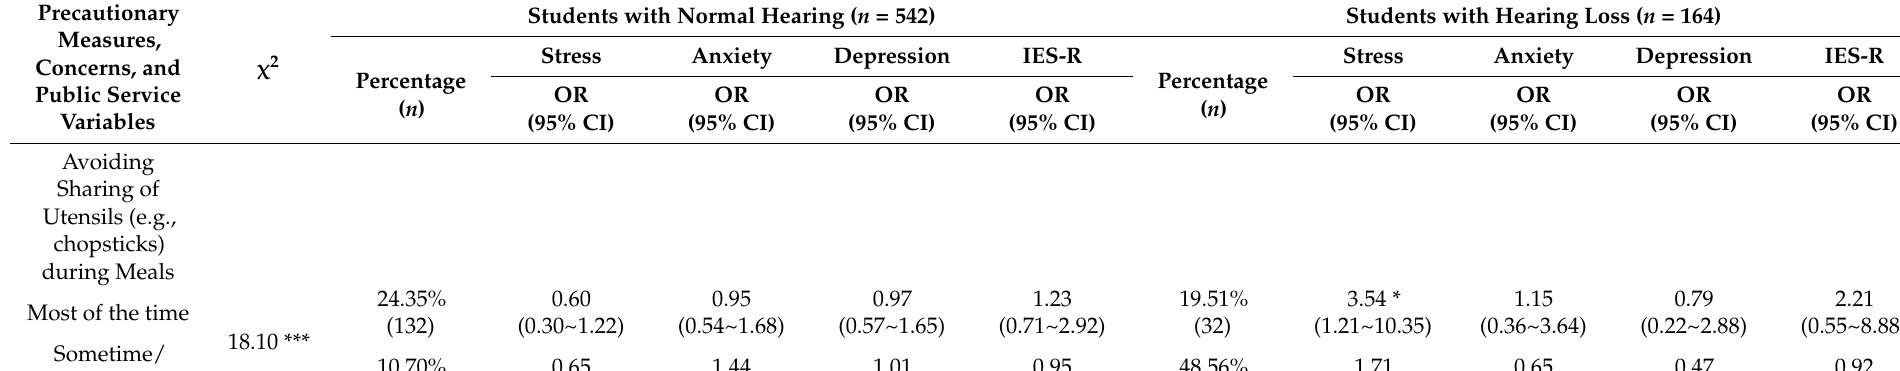
Table 2. Association of precautionary measures, concerns, and public service related to COVID-19 with the mental health status and psychological impact for students with normal hearing ( n = 542) and students with hearing loss ( n =